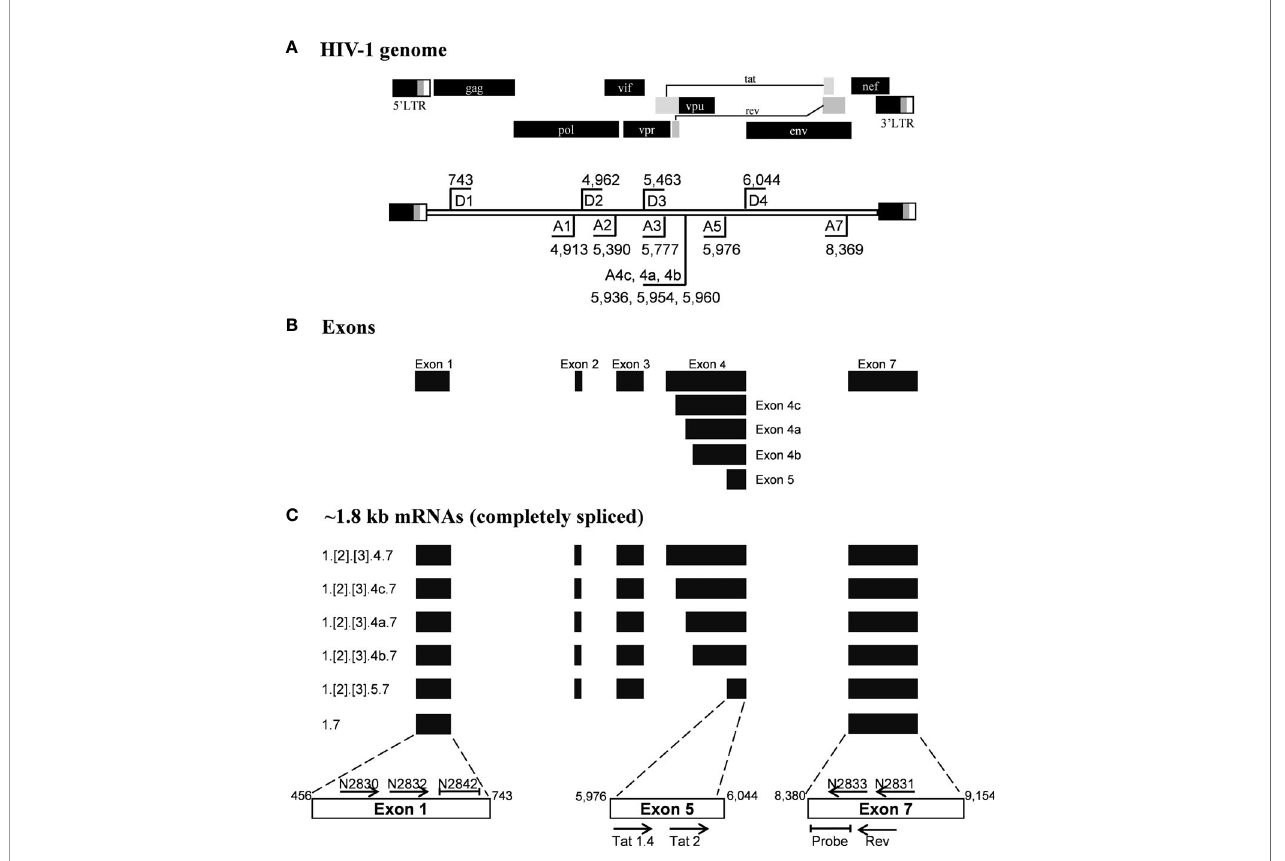
FIGURE 1 | Schematic representation of the HIV-1 exon pro fi le, early transcripts, and primers. (A) A schematic presentation of HIV-1 genome (Upper panel). The locations of splice donor (D1-D4) and splice acceptor sites (A1-A5, A7) are depicted on the HIV-1 genome fl anked by the LTRs (Lower panel). The schematic is not drawn to the scale. The coordinates presented are as per the HIV-1 genome of the HXB2 reference molecular clone. (B) The major exons of HIV-1 are represented by solid horizontal bars. (C) The pro fi le of the early viral transcripts: Several alternatively spliced viral transcripts are formed within the 1.8 kb group. Numbers at the left margin depict the exons that are spliced together to form a speci fi c viral transcript. The exons shown in square brackets are included differentially in the transcript formation. The horizontal arrows depict the primers used in the assays and their orientation. The primer positioning is not to the scale. The primers and probes shown above the open boxes are used in the present work, and those shown below the boxes were reported previously by Procopio et al. Note that the non-coding exon-1 and the 3 ’ -end exon-7 are present in all the viral transcripts, regardless of the splicing